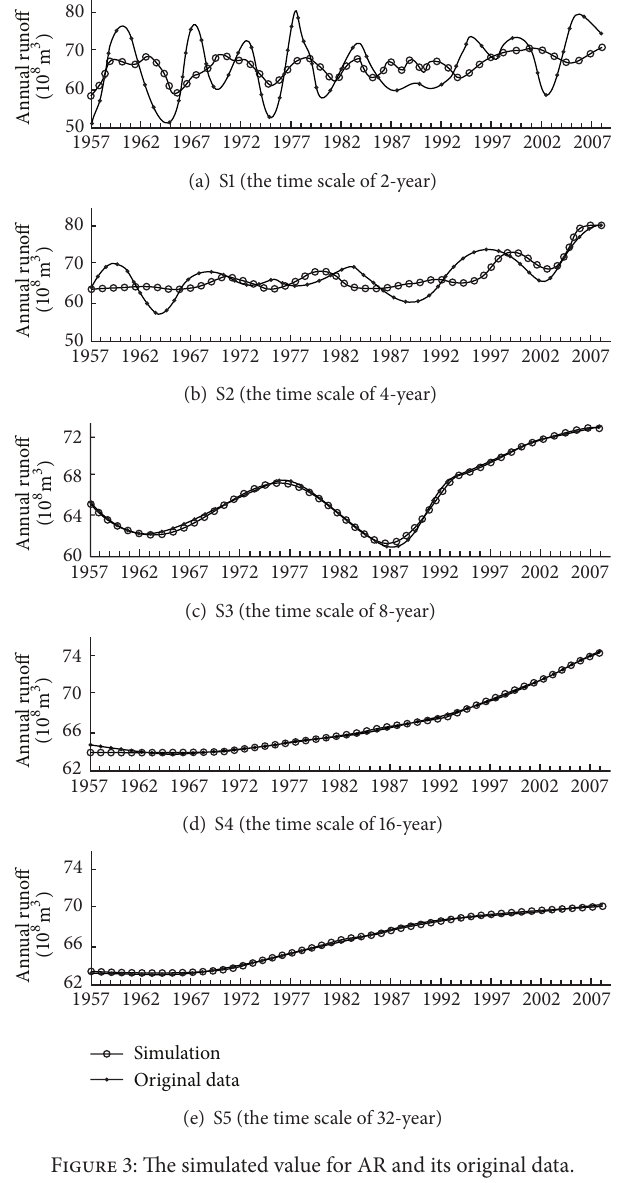
Figure 3: The simulated value for AR and its original